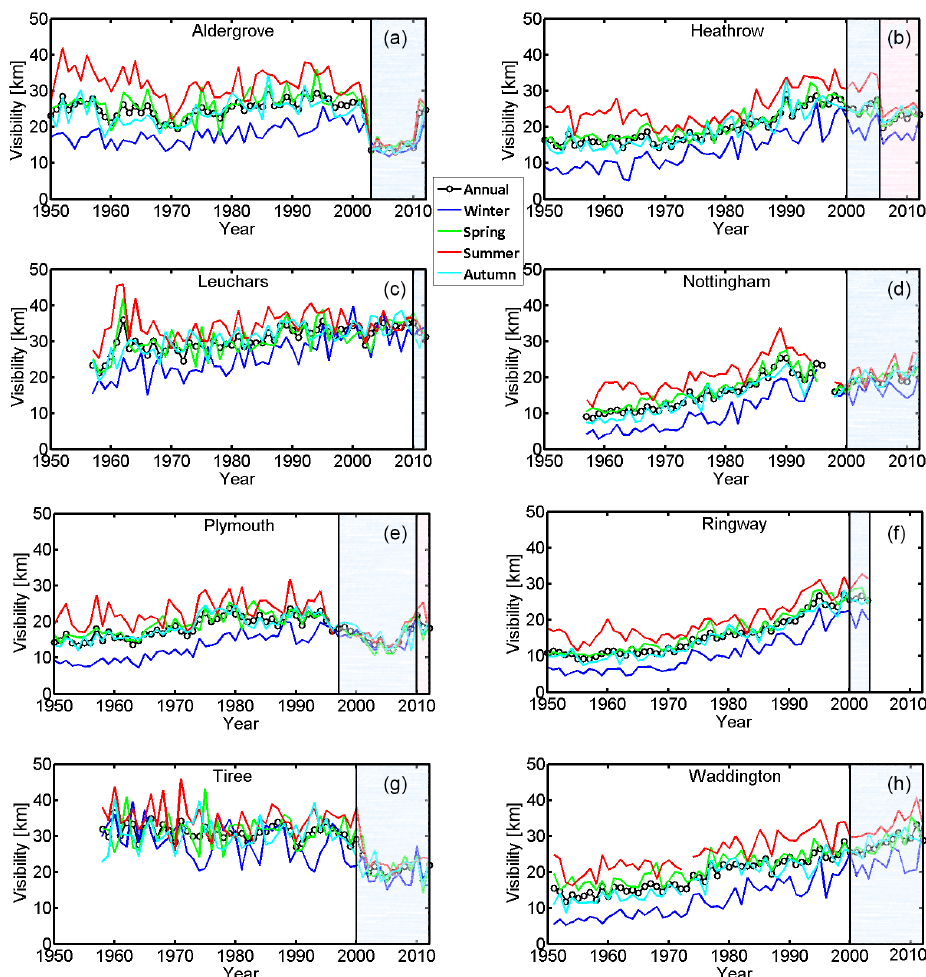
Figure 2. Historical trend of annual and seasonal visibility derived from daily (12:00) observations by station: (a) Aldergrove (b) Heathrow, (c) Leuchars, (d) Nottingham, (e) Plymouth, (f) Ringway, (g) Tiree, (h) Waddington. Shading indicates changes in measurement method- ology, where white is human observation, while blue and red are automated observation using different instruments. For further details see Table